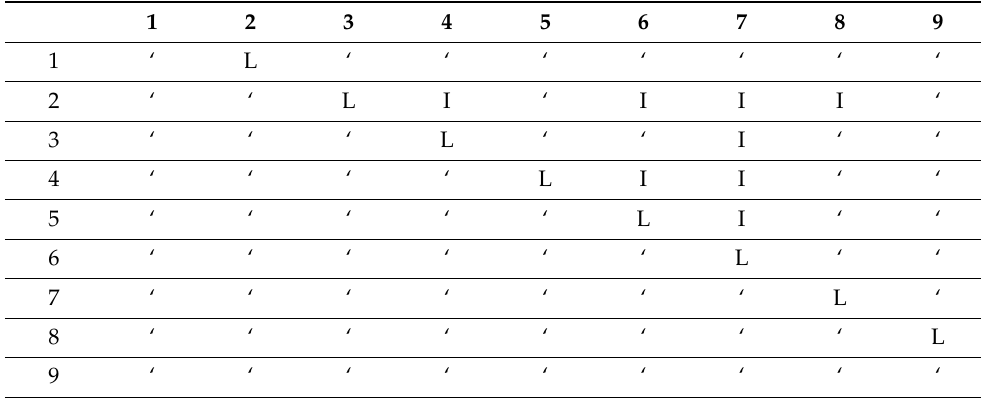
Table 3. Transition matrix for